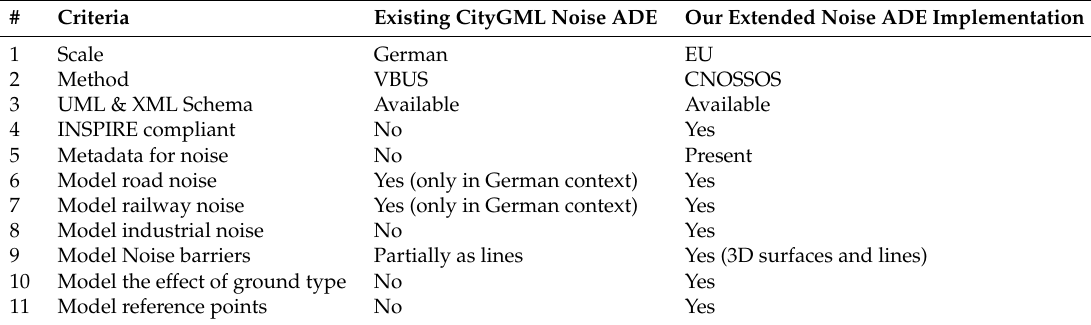
Table 2. Comparison of the existing CityGML Noise ADE with our Extended Noise ADE